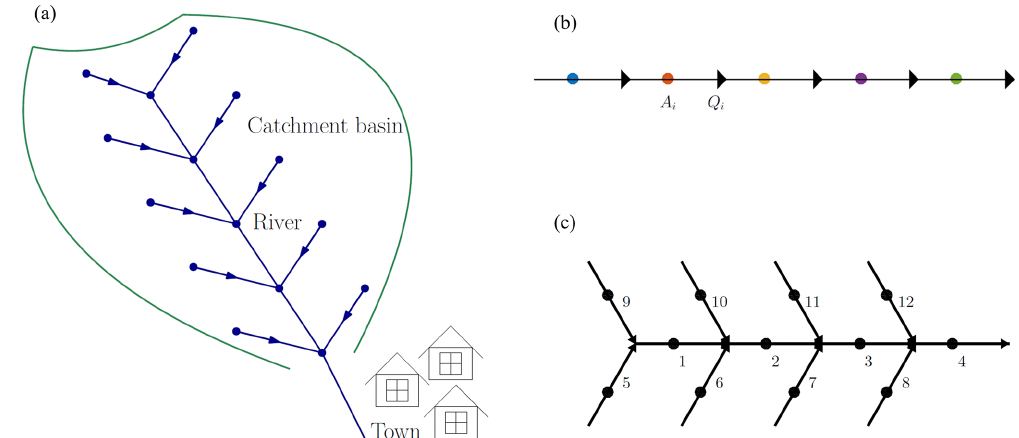
Figure 2. Schematic (a) and the 1D network (b) and 2D network (c) leaky barrier configurations investigated. Triangles indicate the location of dams which control the discharge, Q i associated with the upstream reach where the average cross section is A i . The lengths of the network edges can be varied depending on the scale of interest; in the examples shown in this paper they are typically on the order of 100m